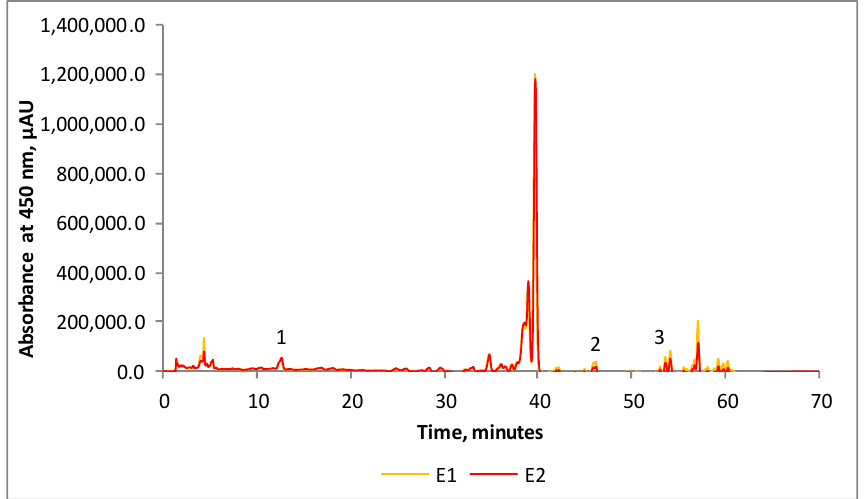
Figure 1. Chromatographic profile of carotenoids from SBP oleoresins (peak 1—zeaxanthin; peak 2—lycopene; peak 3— β -carotene).